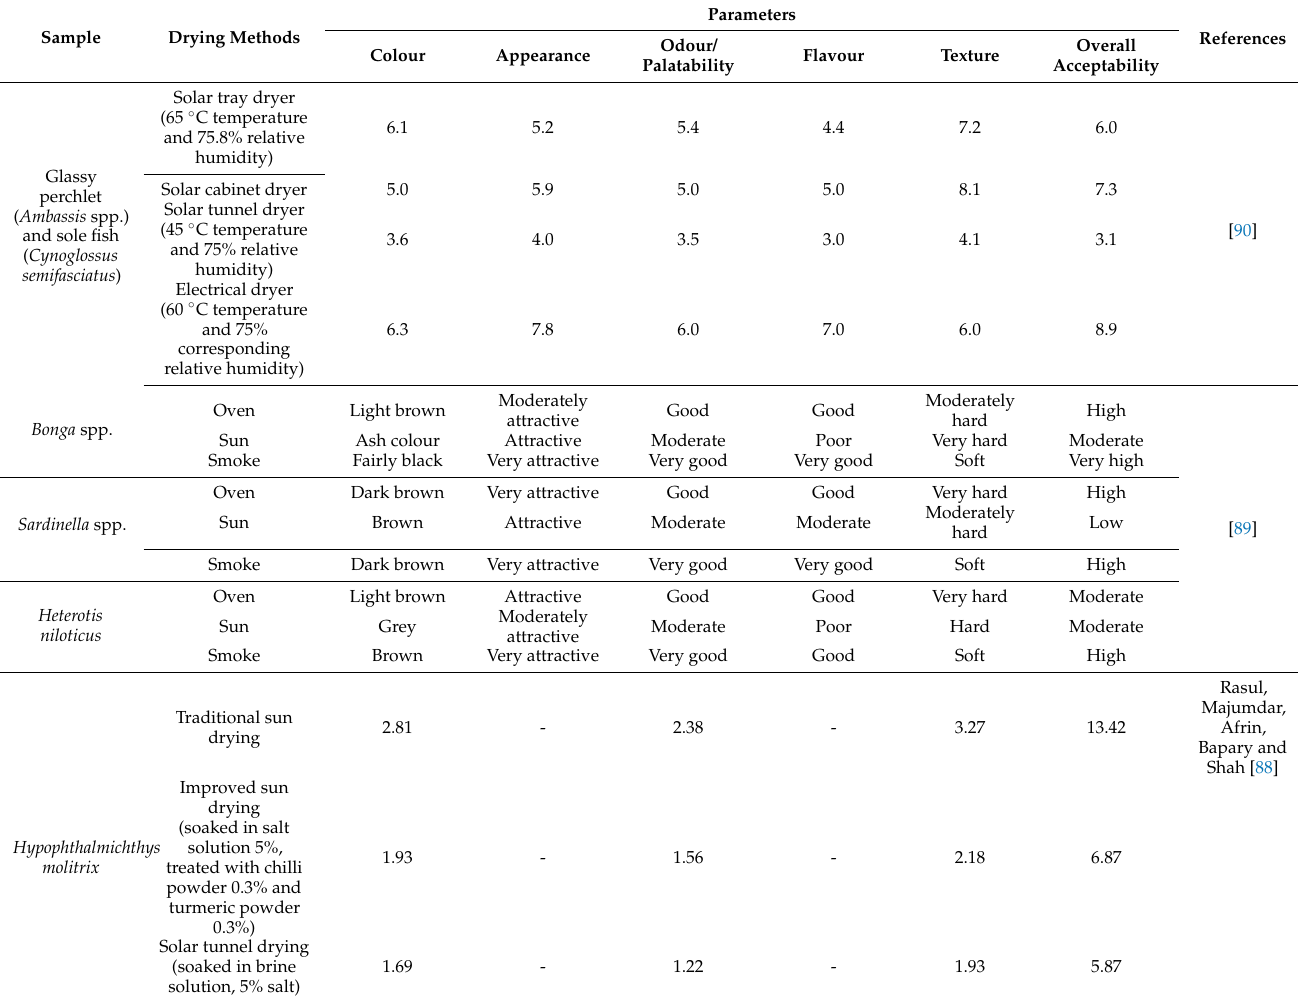
Table 2. The effect of drying methods to the sensory characteristics of dried